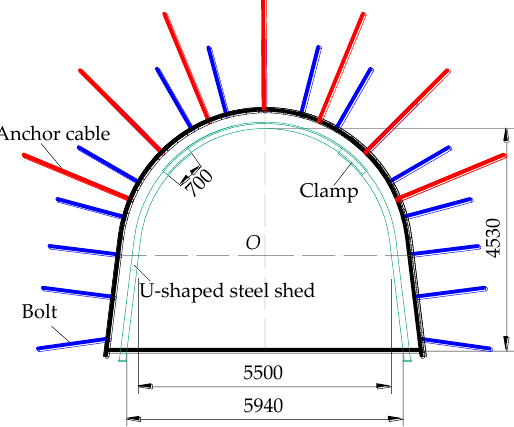
Figure 6. Secondary shed passive support scheme (Unit: mm).